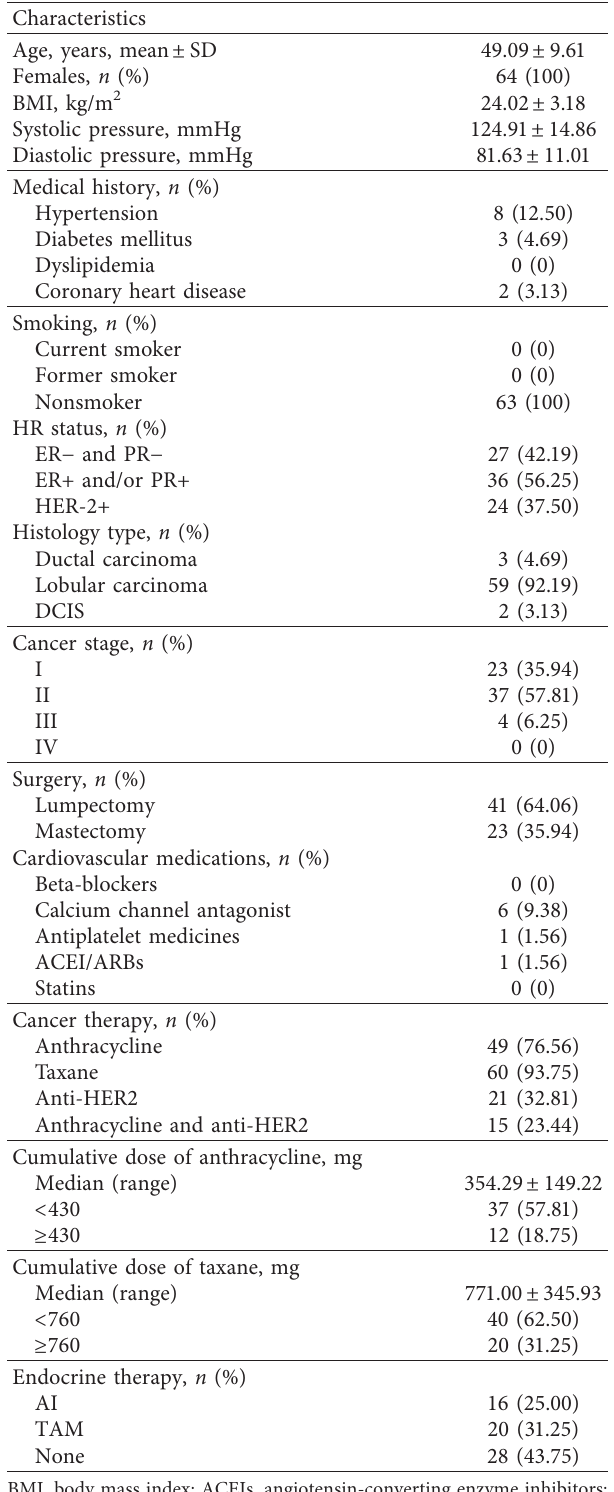
Table 1: Baseline clinical characteristics and cardiovascular risk factors in breast cancer